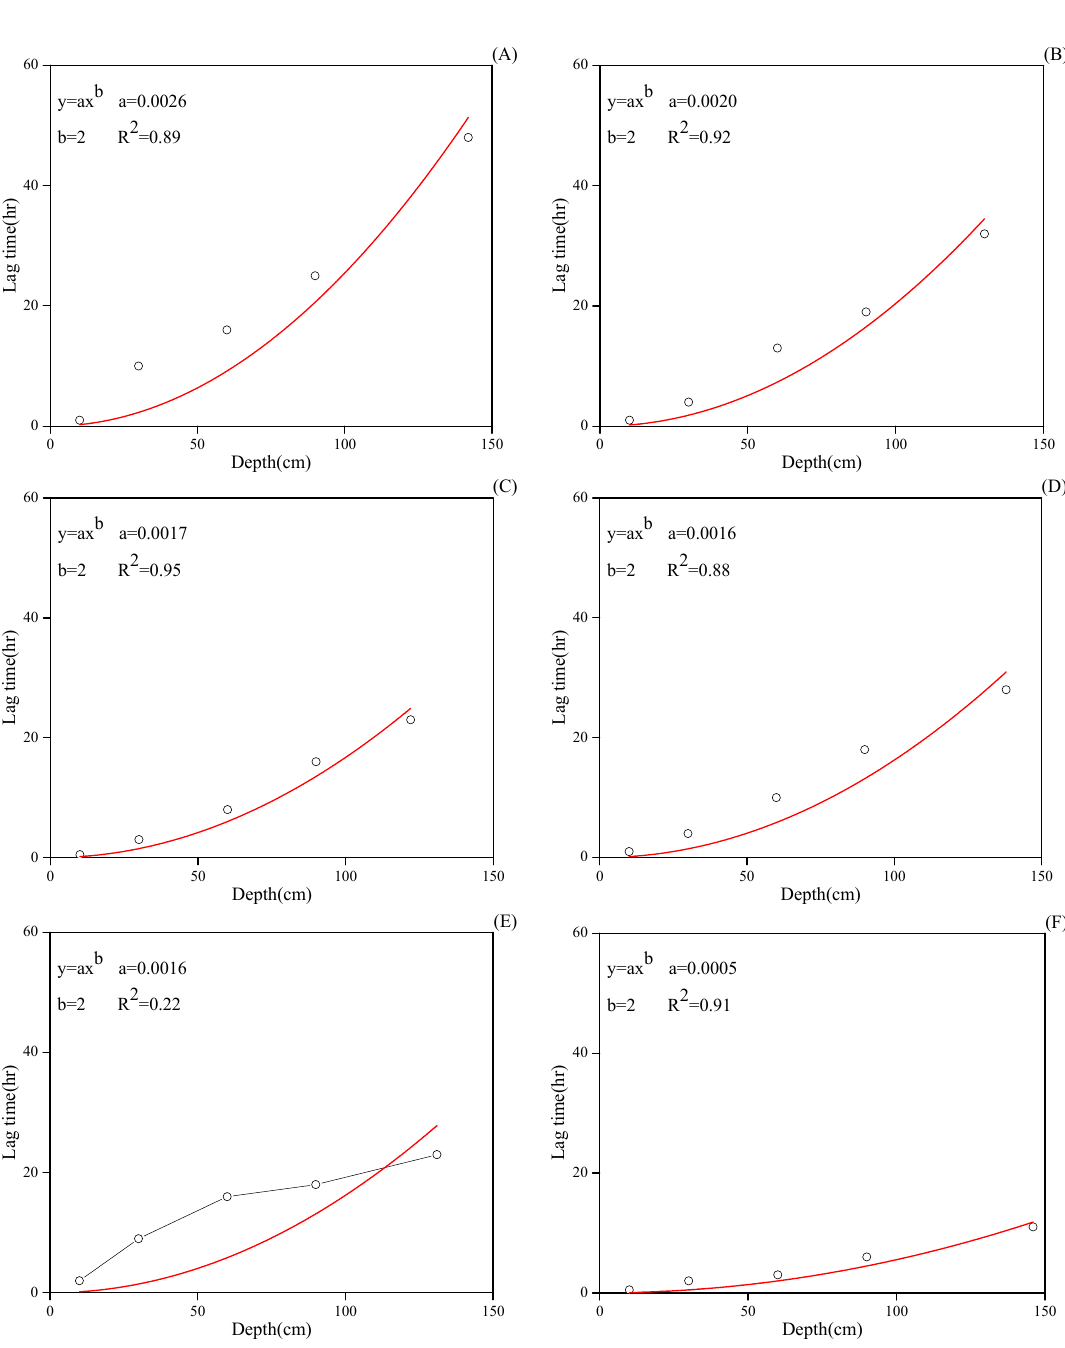
remains. The plot (E) shows that lag time increased very slowly as soil depths go deeper, opposite to the other plots. The obvious change in slope (about lag time at 17 h) on the data curve in (E) suggests that the moving speed of the infiltration front was greater after 17 h. This may be caused by the different rain patterns between (E) and the others. The total rainfall of (E) was 41.4 mm but